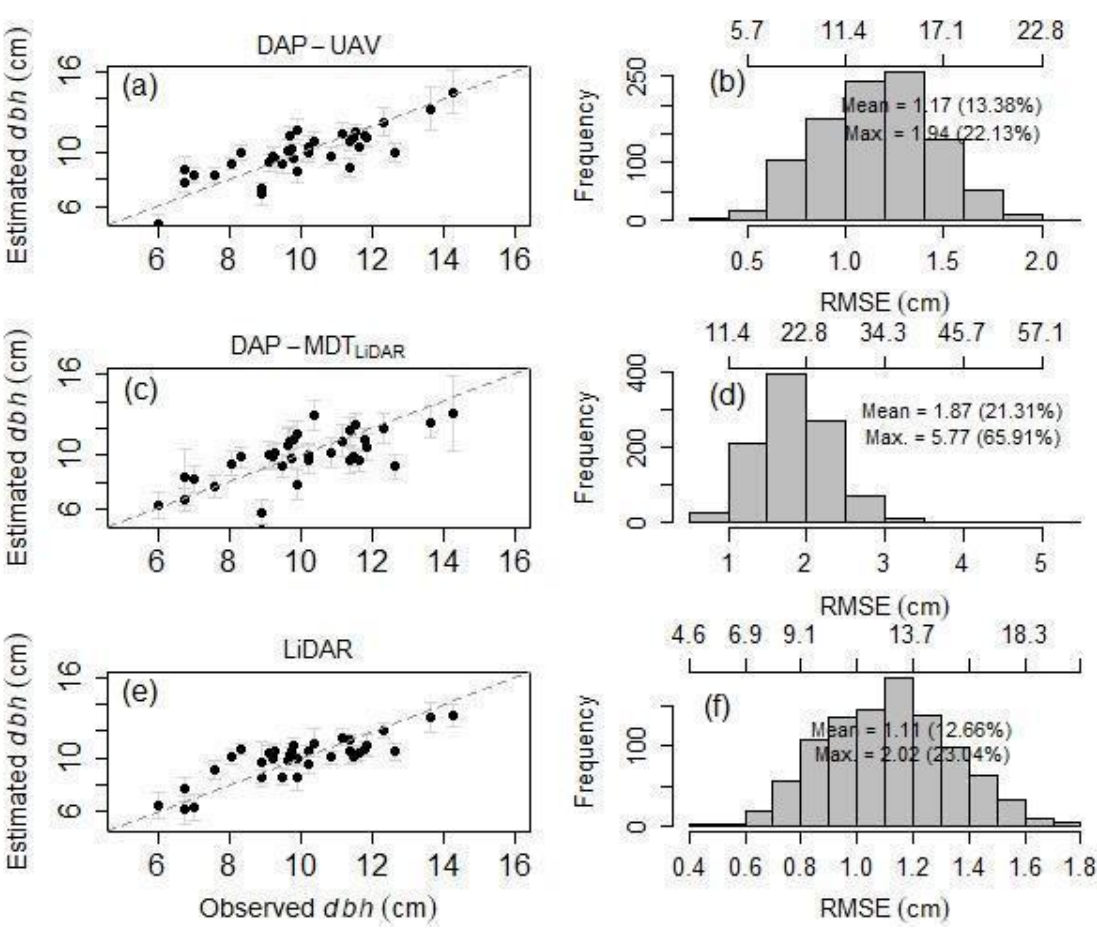
Figure 11. Dispersion plots between the estimated and observed average dbh values of ( a ), ( c ), and ( e ) and the frequency histograms of RMSE in the validation of models ( b ), ( d ), and ( f ) for DAP-UAV, DAP-DTM LiDAR , and LiDAR.